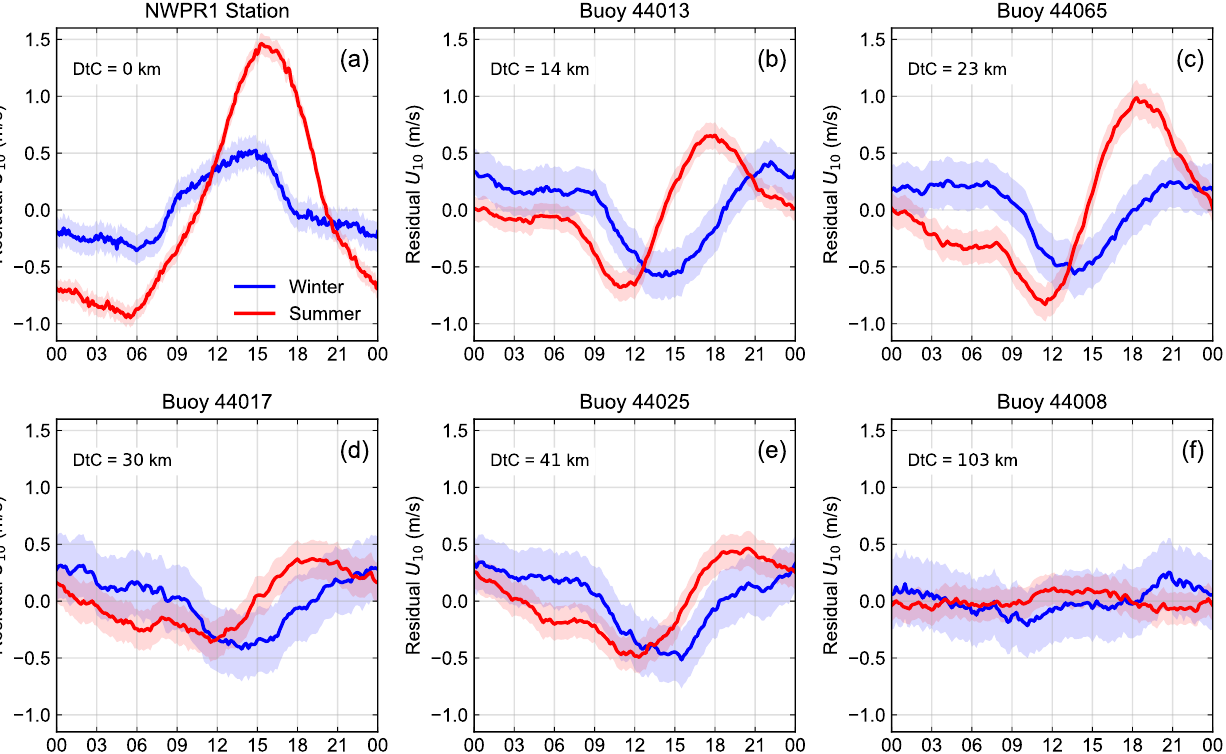
Figure 3. The u 10 diurnal cycle at ( a ) station NWPR1 (Newport, RI) and ( b – f ) NDBC buoys for the winter (blue color) and summer (red color) seasons. The shaded area represents the 95% confidence interval. DtC is each station’s distance to the closest